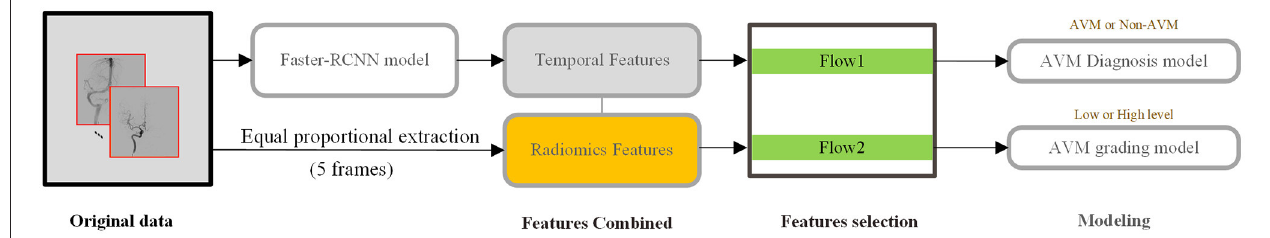
DSA ( Table 4 ). Receiver operating characteristic (ROC) curves of the three features group are summarized in Figure 7